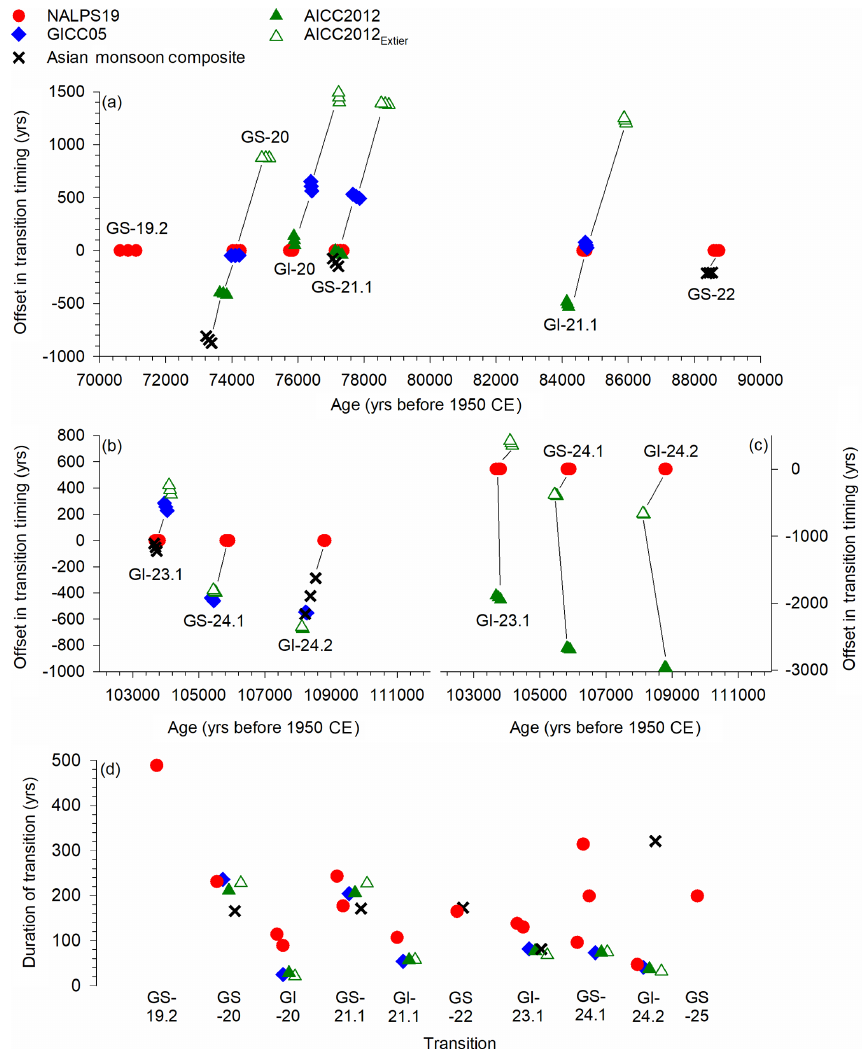
Figure 5. (a, b, c) Offsets in absolute chronology relative to NALPS19 of transitions into stadials and interstadials as defined by the ramp- fitting applied in this study. ( + ) values indicate the timing in the respective chronology is older/earlier than in NALPS19. ( − ) values indicate the timing in the respective chronology is younger/later than in NALPS19. Lines are used to indicate the same transition. (d) Duration of transitions. NALPS19 (red circles; this study); NGRIP on GICC05 modelext chronology (blue diamonds; Wolff et al., 2010); NGRIP on AICC2012 chronology (green triangles; Veres et al., 2013); NGRIP on Extier et al. (2018) revised AICC2012 chronology (open green triangles); Asian monsoon composite speleothem (black crosses; Kelly et al., 2006; Kelly, 2010; Cheng et al.,